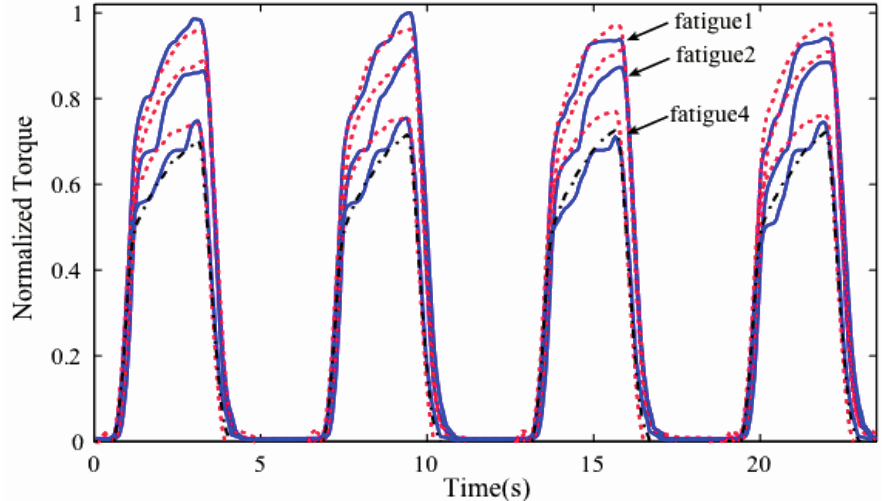
Figure 2. An example of a predicted torque obtained by eEMG-torque model using FES evoked fatigue induced protocol in SCI population. The blue solid line and the red dotted represent the measured and predicted torque, respectively